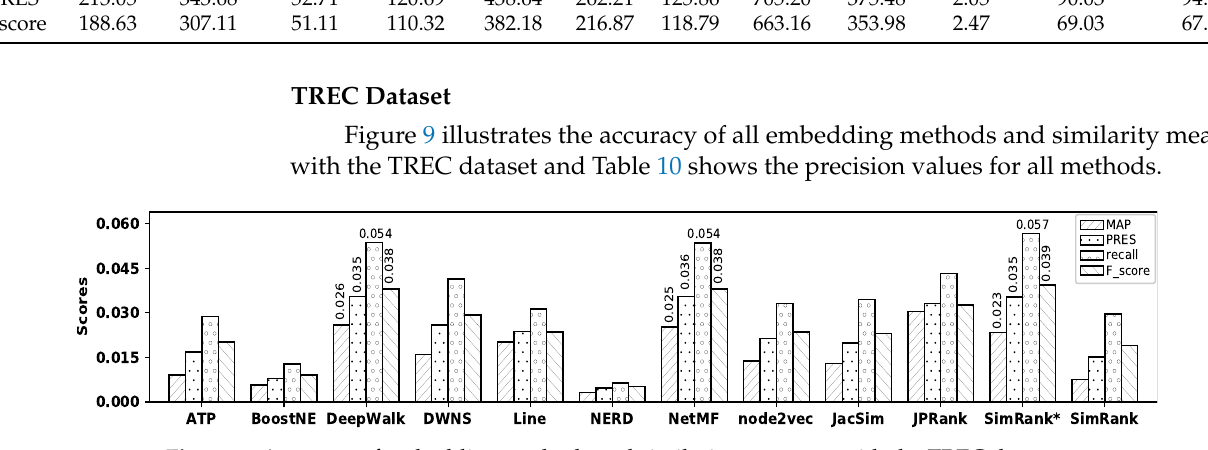
Figure 9. Accuracy of embedding methods and similarity measures with the TREC dataset. Table 10. Precision values with the TREC dataset.